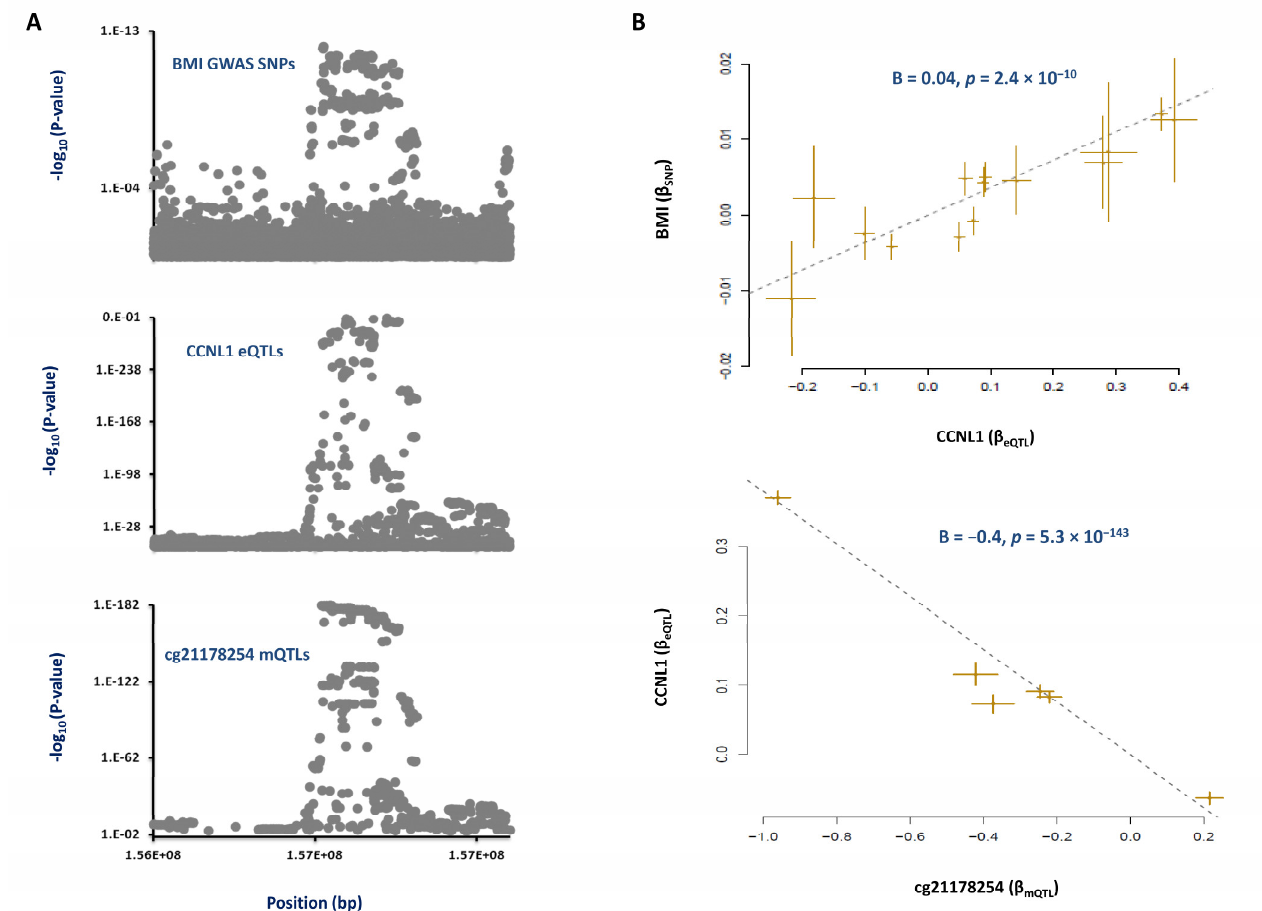
Figure 2. Mechanism whereby the cg20892840 site upstream of CCNL1 impacts obesity. ( A ) We found that regional association plots for mQTLs of cg20892840, eQTLs of CCNL1 and risk SNPs of obesity co-localize. ( B ) MR analysis then revealed that, as cg20892840 becomes hypomethylated, the expression of CCNL1 increases, and this contributes to a higher BMI. Each point represents a SNP; the x-value of a SNP is its β effect size on the exposure, and the horizontal error bar represents the standard error around the β. The y-value of the SNP is its β effect size on the outcome, and the vertical error bar represents the standard error around its β. The dashed line represents the line of best fit (a line with the intercept of 0 and the slope of β from the MR test).